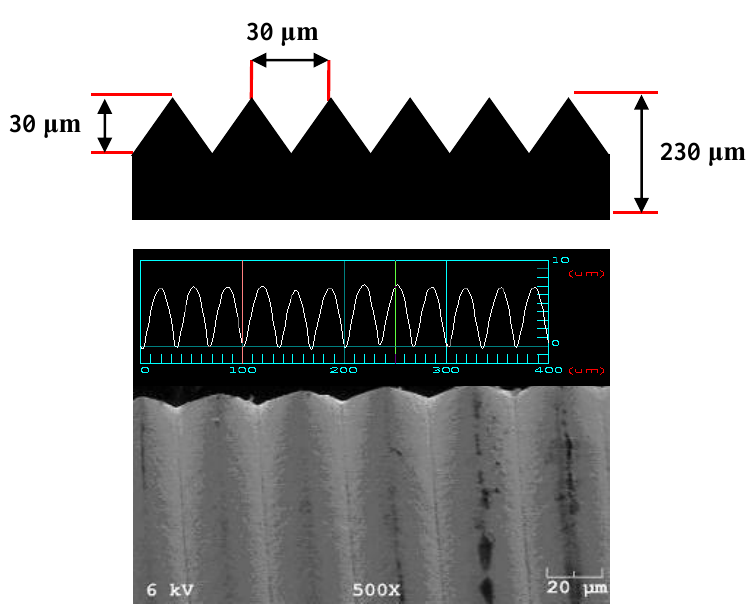
Figure 6. Sawtooth microfeatures on the belt